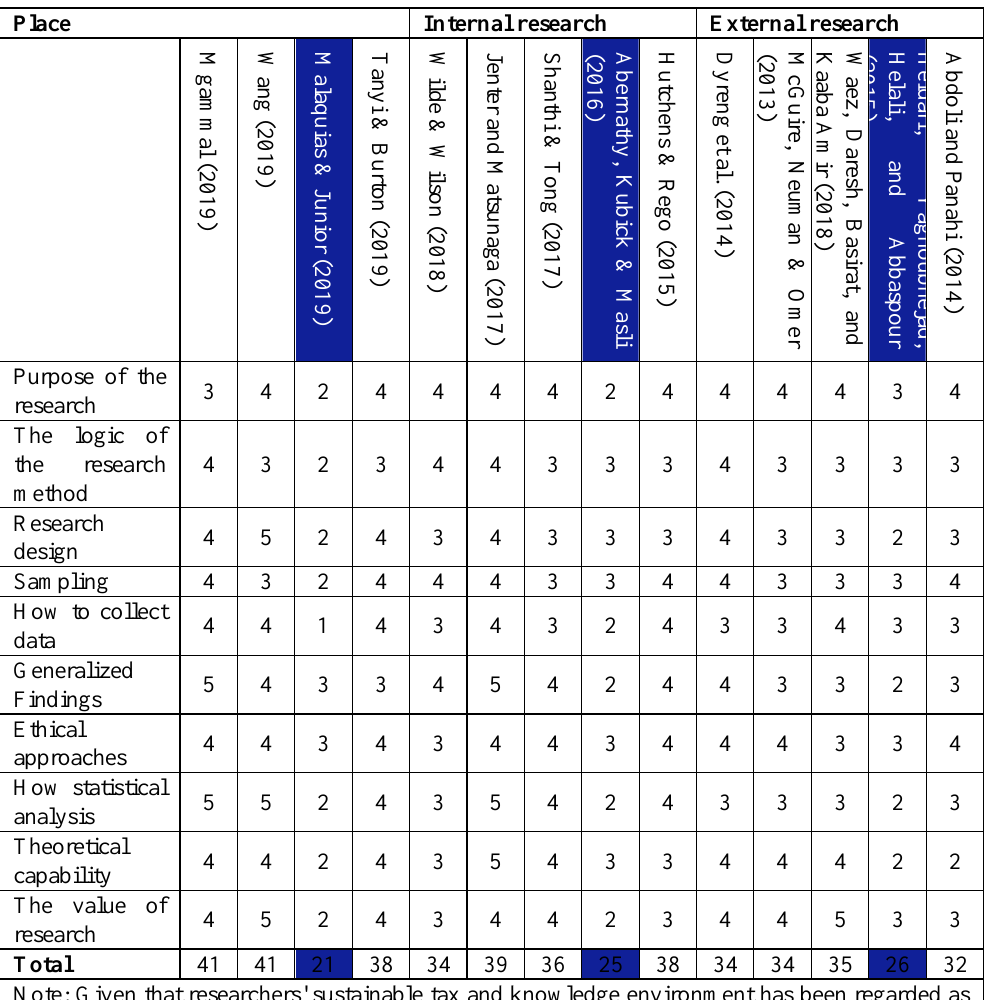
Table 1. Critical evaluation of the studies